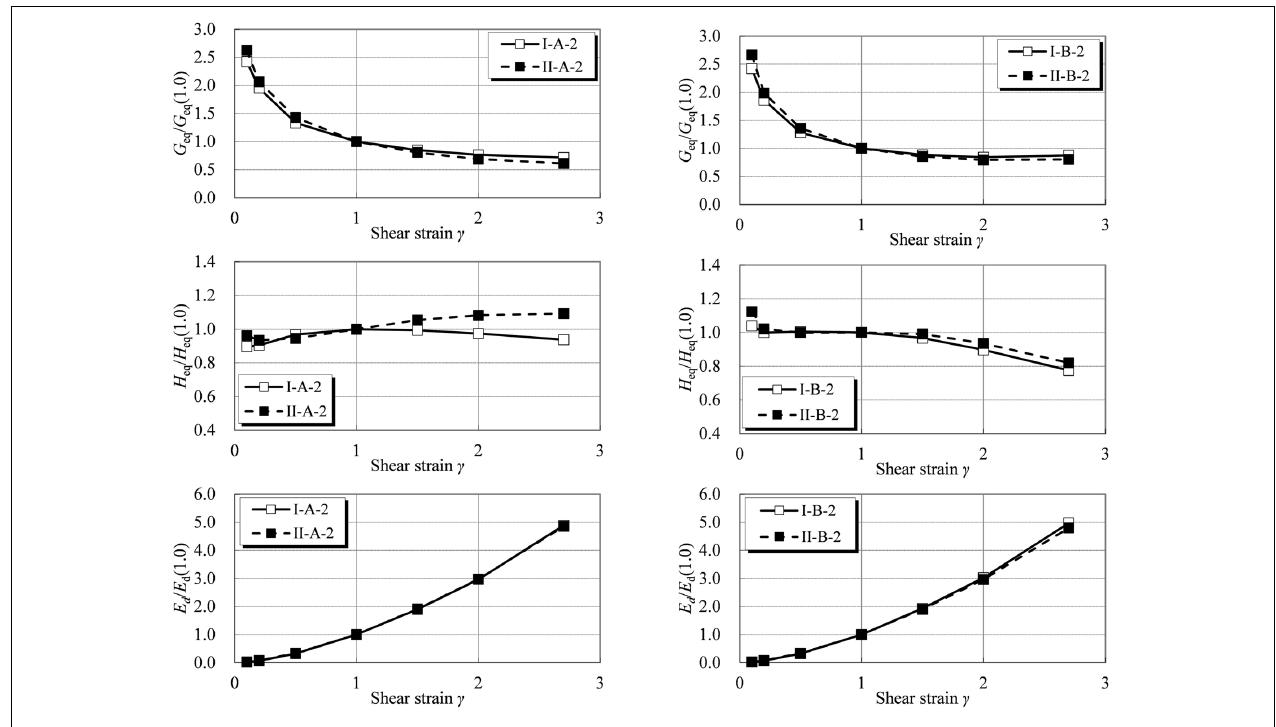
FIGURE 8 | Comparison of shear strain dependency of scale-I and -II at 3rd cycle.